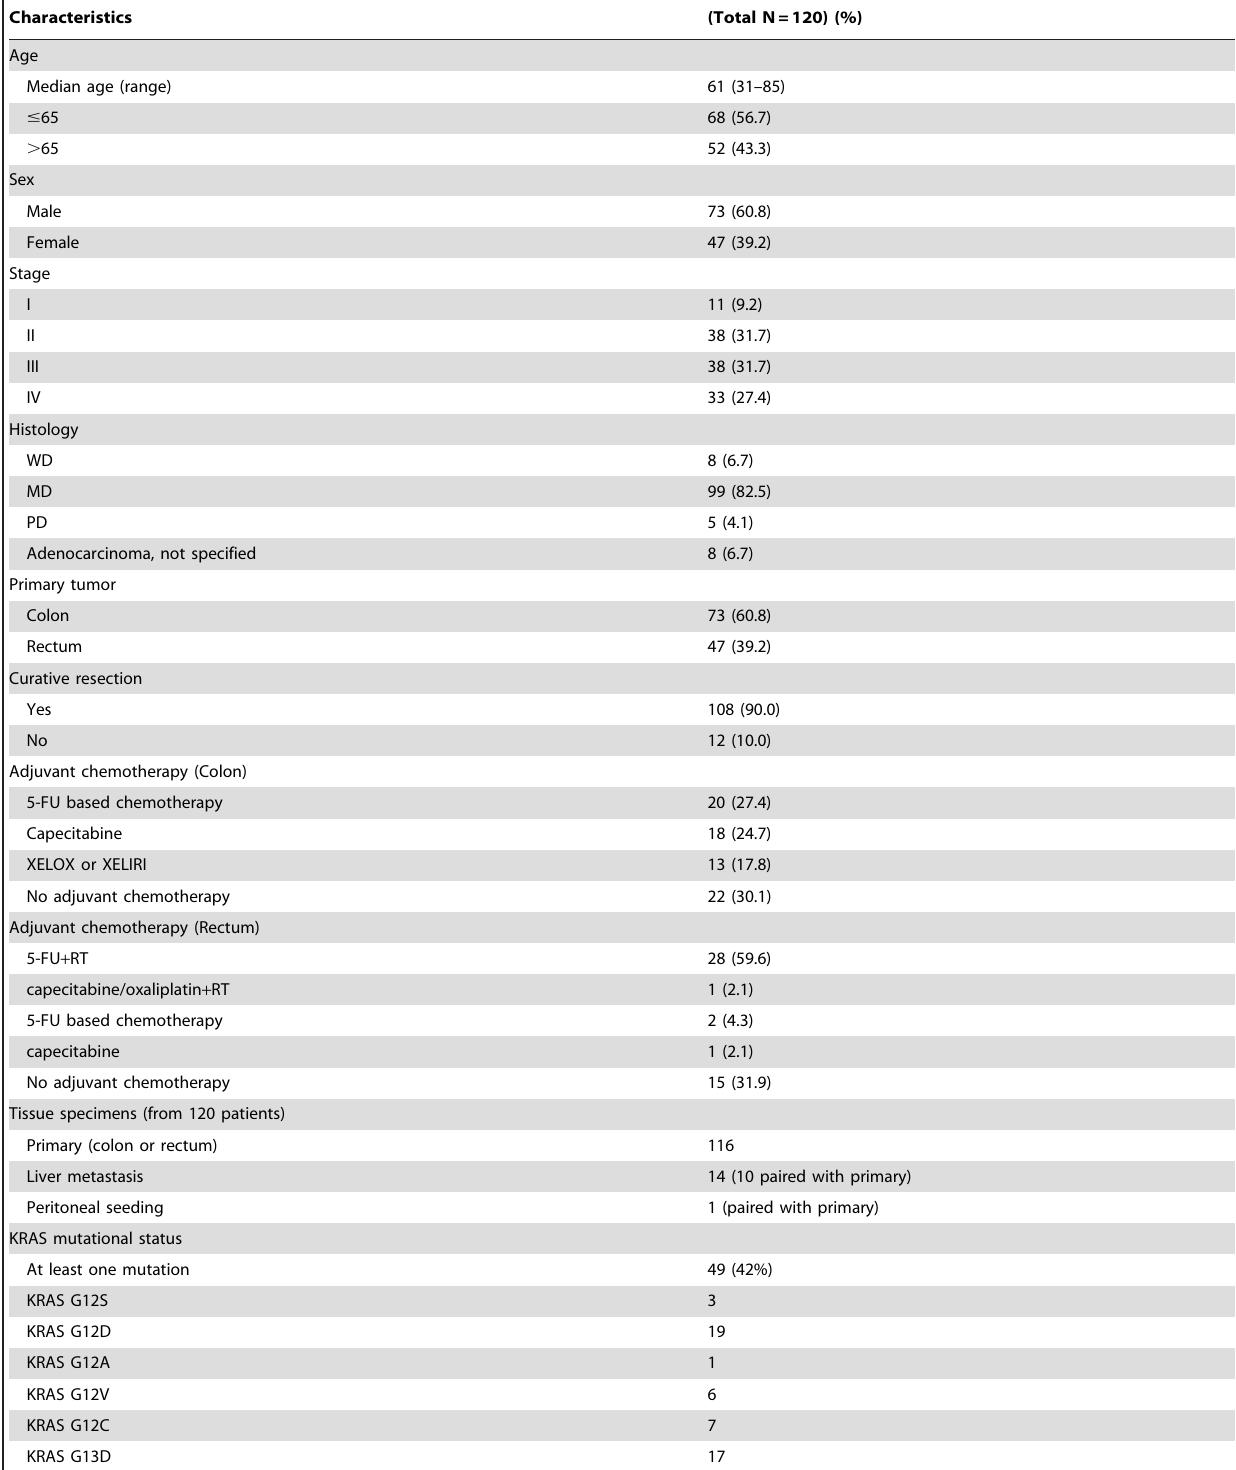
Table 1. Patient characteristics.